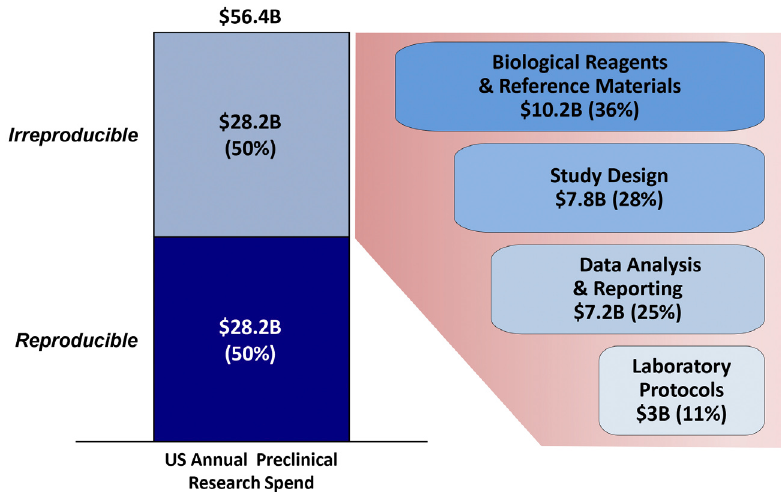
Figure 2. The magnitude of the reproducibility crisis and key sources of irreproducibility. Figure adapted from